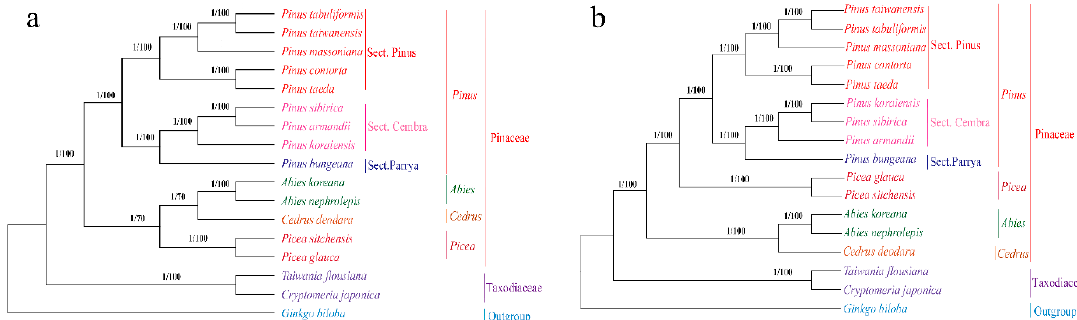
Figure 6. Phylogenetic tree constructed by maximum likelihood (ML) and Bayesian inference (BI) methods based on whole chloroplast genome sequences and 56 shared protein-coding genes of 16 conifers. ( a ) Phylogenetic tree based on whole chloroplast genome sequences of 16 conifers; ( b ) Phylogenetic tree based on 56 shared protein-coding genes of 16 conifers chloroplast genomes; Ginkgo biloba as an outgroup; BI posterior probability/ML bootstrap support values were listed at each node.